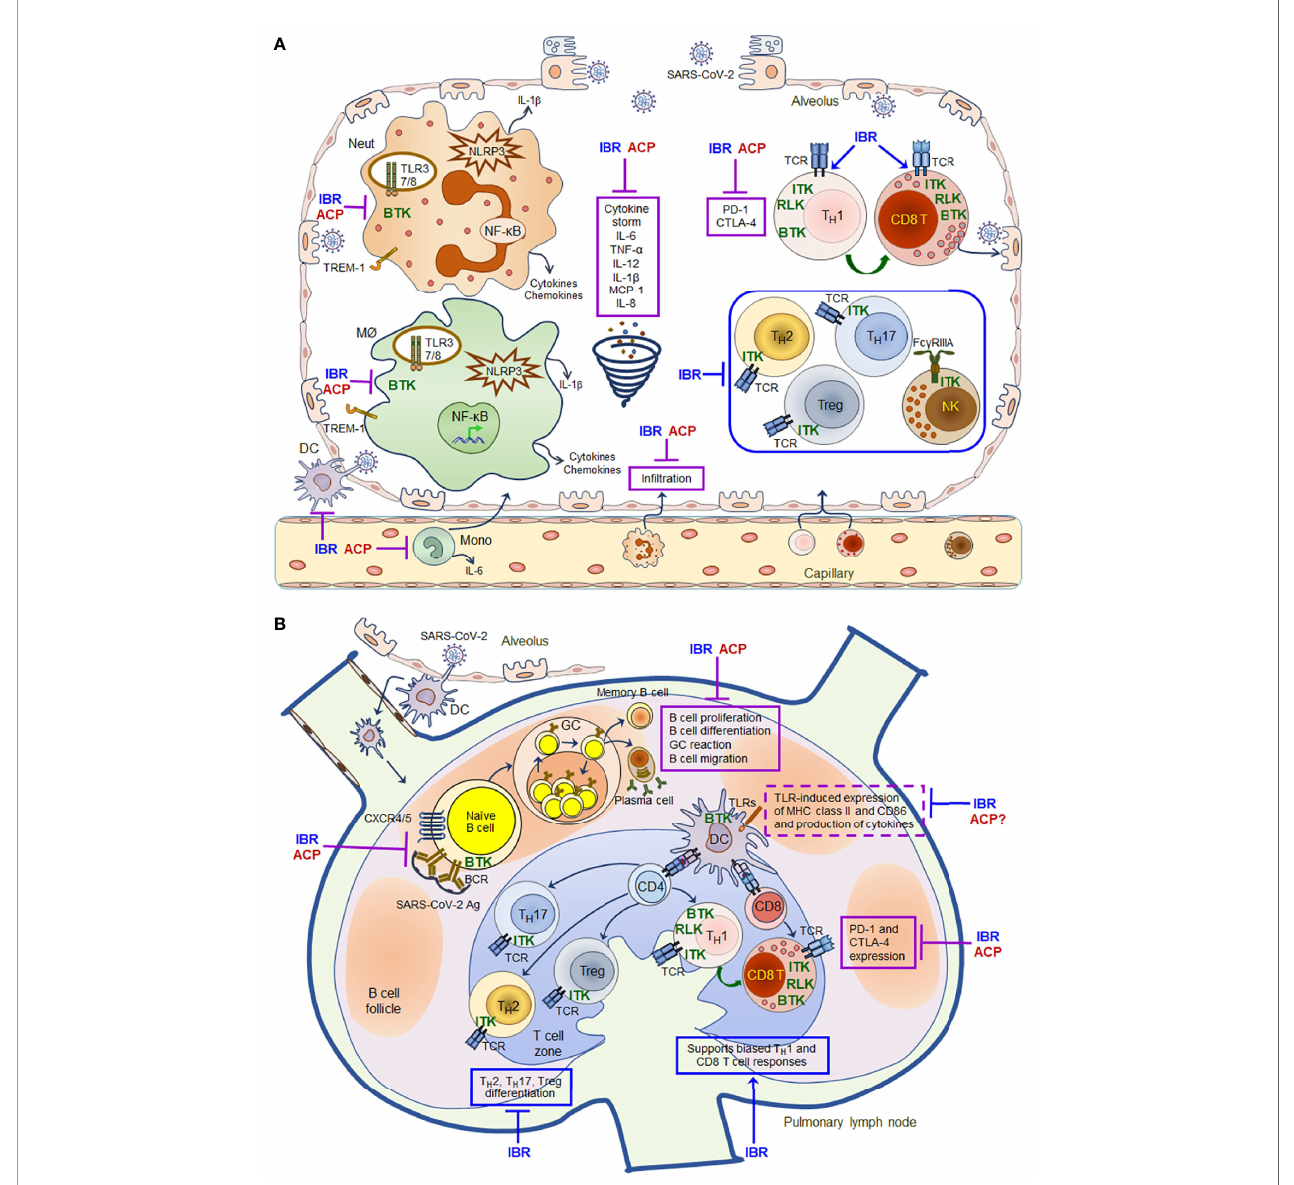
FIGURE 1 | Schematic mechanisms of action for ibrutinib and acalabrutinib in the lung of patients with severe COVID-19. A model of mechanisms of action for ibrutinib (IBR) and acalabrutinib (ACP) is proposed based on the evidence that both drugs have protective effects on ARDS in patients with severe COVID-19 and that both drugs have multifaceted immunomodulatory effects on different immune cell subsets. (A) Inhibitory effects of ibrutinib and acalabrutinib on cytokine storm in the alveolus. (B) Immunomodulatory effects of ibrutinib and acalabrutinib on B cell and T cell responses in pulmonary lymph nodes. Both drugs can inhibit monocyte, macrophage and neutrophil activation induced by TLRs, NLRP3, TREM-1 and Dectin-1 via BTK-dependent mechanisms, thereby decreasing the production of in fl ammatory cytokines and chemokines such as IL-6, TNF a , IL-12, IL-1 b , MCP-1 and IL-8 to ameliorate cytokine storm. Both drugs also inhibit the expression of PD-1 and CTLA-4 on activated T cells via BTK-dependent mechanisms, thus enhancing T cell anti-viral immunity. In addition, ITK-dependent effects of ibrutinib on T cell differentiation, effector function and survival may also contribute to its modulatory effects on immunopathology and lymphopenia in COVID-19 therapy, skewing T cells to a T H 1- and CD8 cytotoxic T cell-dominant populations by inhibiting T H 2/T H 17/Treg differentiation, and thus promoting T H 1 immunity and CD8 cytotoxic effector functions. However, both drugs can suppress the proliferation, differentiation, GC reaction and migration of SARS-CoV-2-speci fi c B cells by inhibiting BCR and CXCR4/CXCR5 signaling via BTK-dependent mechanisms, thereby inhibiting the production of antibodies and memory B cell responses. All the shared effects of both drugs are depicted in solid purple boxes, while the distinct ITK-dependent effects of ibrutinib are depicted in solid blue boxes in the fi gure. Ibrutinib (and likely acalabrutinib) can also affect TLR-induced DC activation and expression of MHC class II and CD86 via BTK-dependent mechanisms (depicted in dashed purple boxes in the fi gure), and therefore may alter DC-mediated antigen presentation. Given the complex protective and undesired immunomodulatory effects of both drugs, the timing and duration of their administration need to be appropriately adjusted and tailored to improve patient outcome according to clinical data obtained from recently completed and ongoing clinical